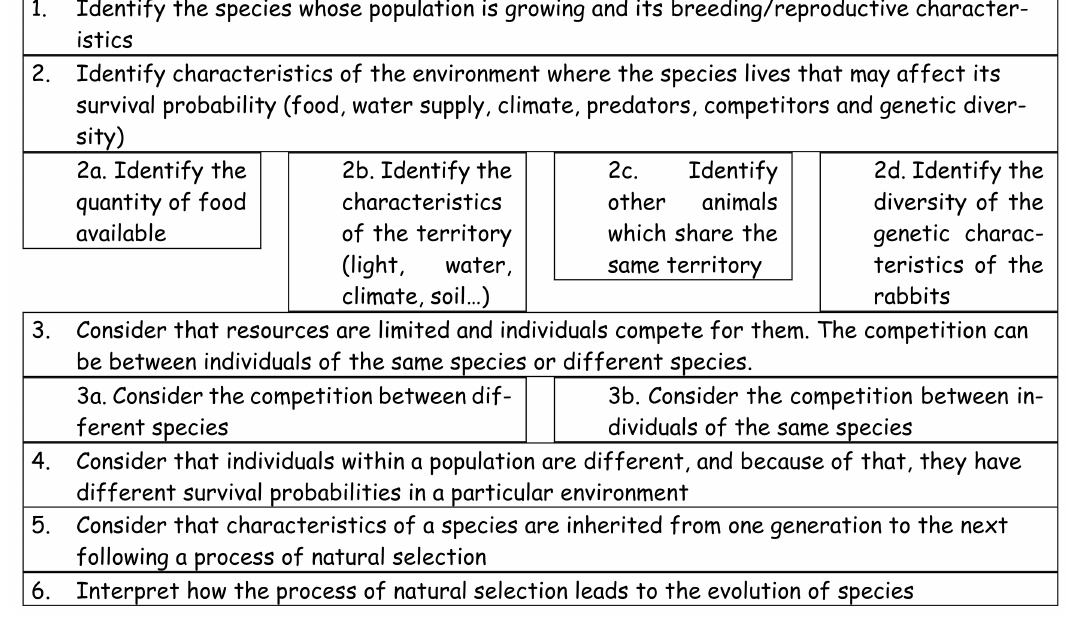
Figure 4. GASS developed in A6 to analyse the growth of a population.